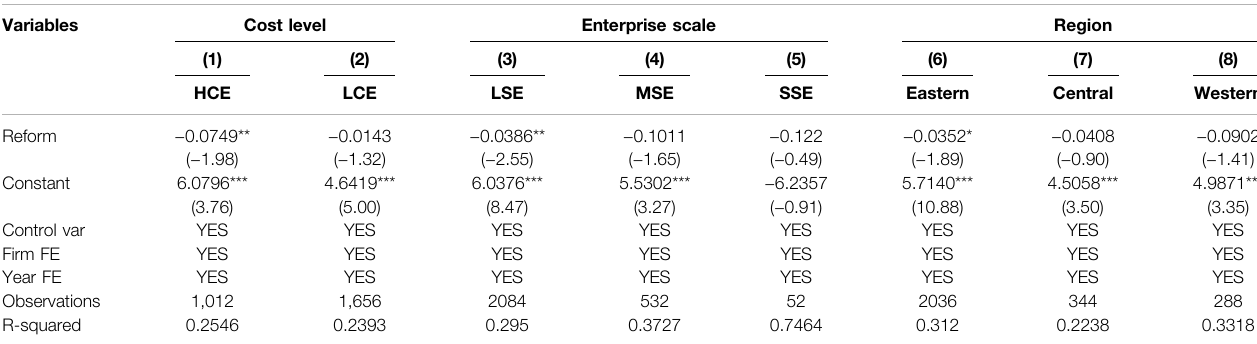
TABLE 9 | Results of heterogeneity